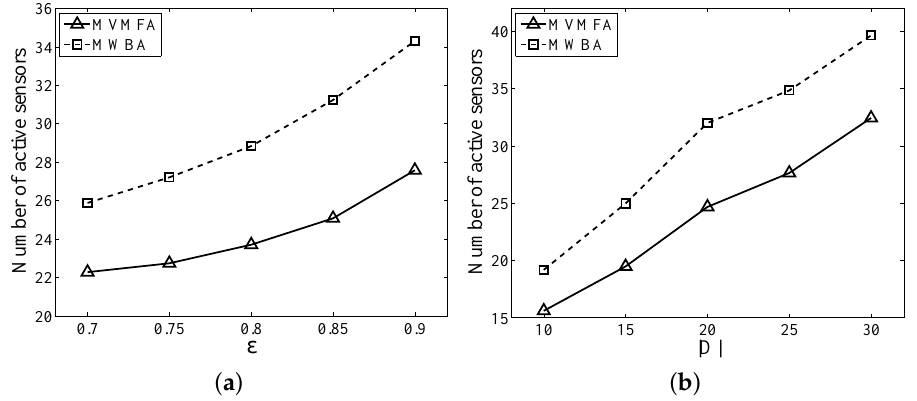
Figure 9. Impacts of (cid:101) ( a ) and | D | ( b ) to MVMFA and the minimum weight barrier algorithm (MWBA).